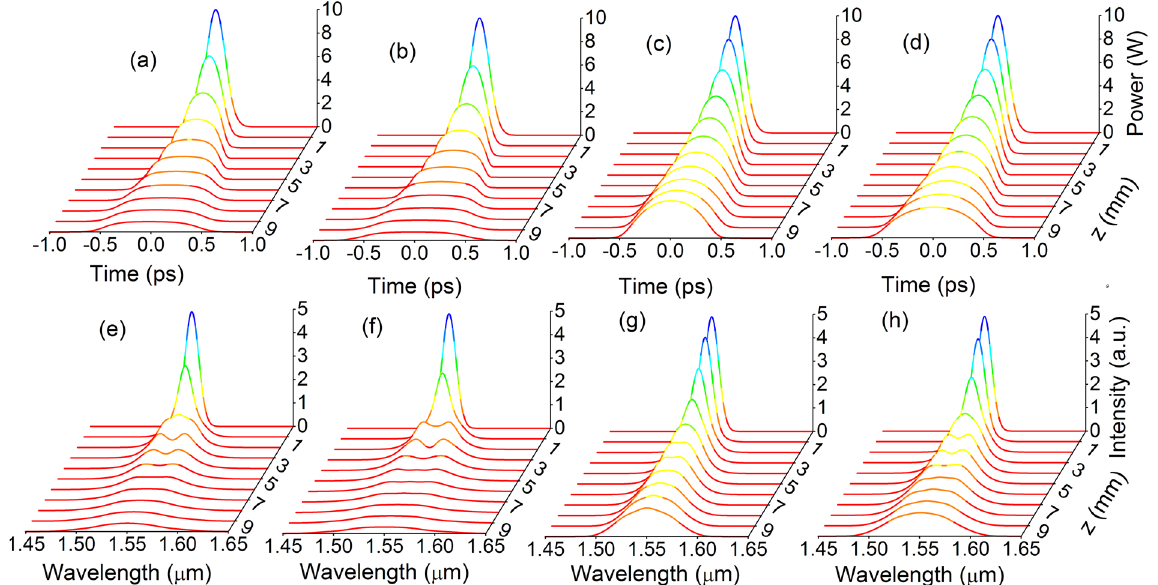
Figure 6. Evolutions of the Gaussian input pulses along the taper modeled by the GNLSE. The evolutions of the waveforms in the top row are obtained in ( a ) NIWs at 1550 nm, ( b ) DDWs at 1550 nm, ( c ) NIWs at 2150 nm and ( d ) DDWs at 2150 nm. The evolutions of the spectra in the bottom row are obtained in ( e ) NIWs at 1550 nm, ( f ) DDWs at 1550 nm, ( g ) NIWs at 2150 nm and ( h ) DDWs at 2150